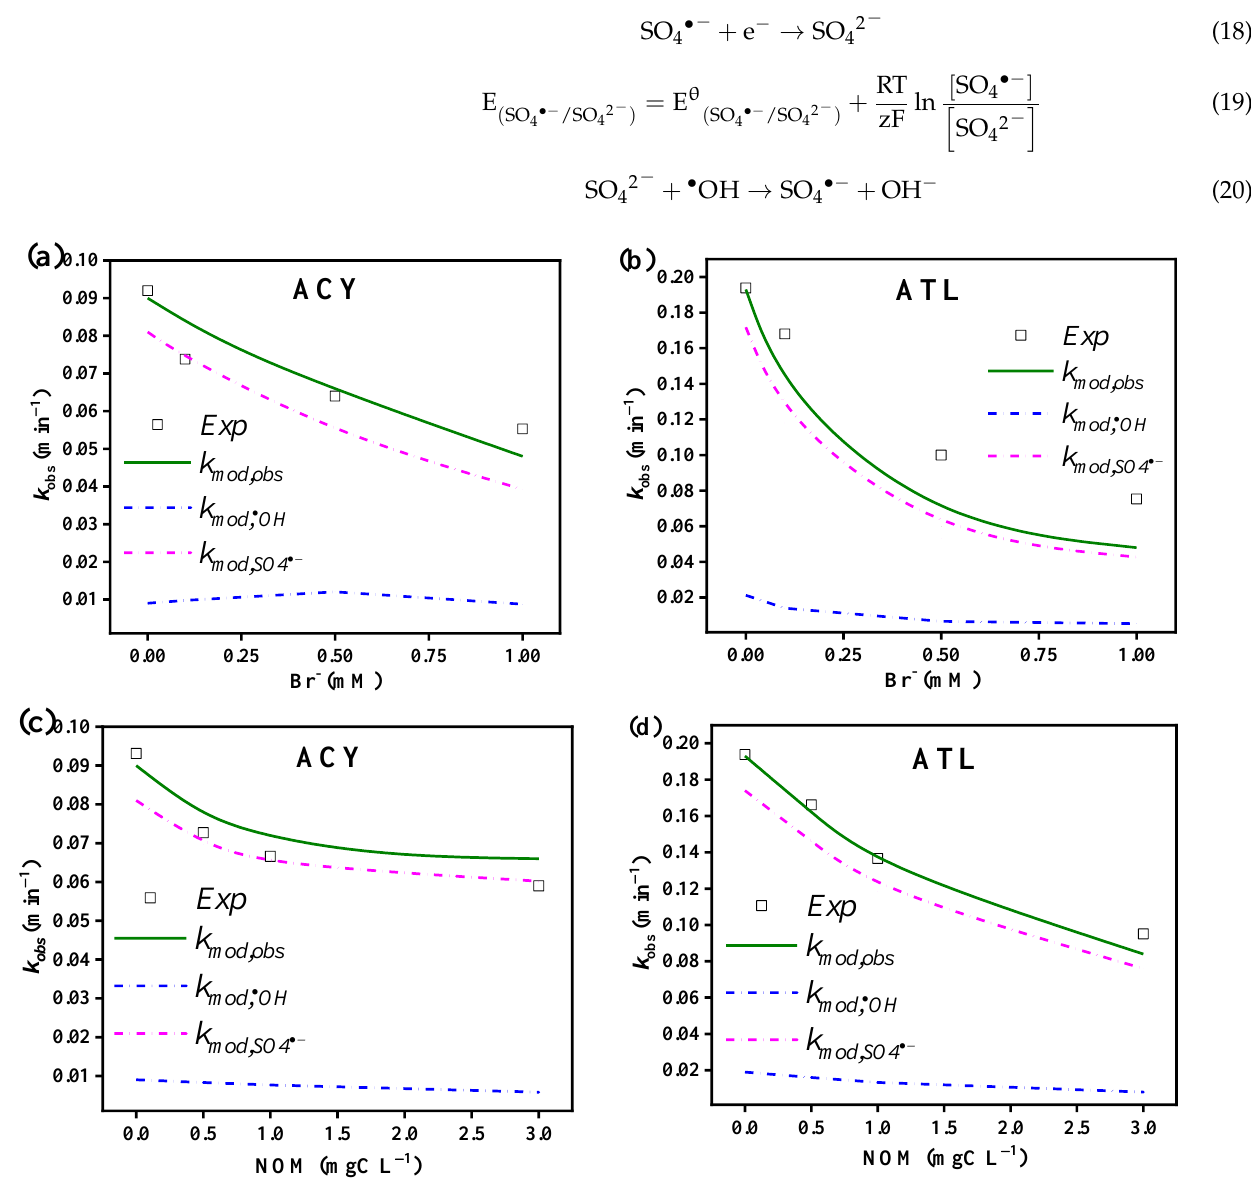
Figure 6. Effect of Br – dosage and NOM on the k obs of ACY ( a , c ) and ATL ( b , d ) degradation and specific rates of • OH and SO 4 •− in UV/PDS process. Conditions: [ACY] 0 = 0.022 mM, [ATL] 0 = 0.019 mM, [PDS] 0 = 0.6 mM, pH = 6.0. NO 3 − (0.5 − 3 mM) visibly inhibited the removal efficiencies of ACY and ATL in the UV/PDS system (Figure S14). The k obs for ACY and ATL decreased by 26.0% and 27.7%, as the NO 3 − concentration rose to 3 mM. The k mod , • OH and k decreased by 18.6 − 37.1% mod , SO •− 4 and 19.2 − 36.3% in the presence of 3 mM NO 3 − , respectively. NO 3 − can be used as